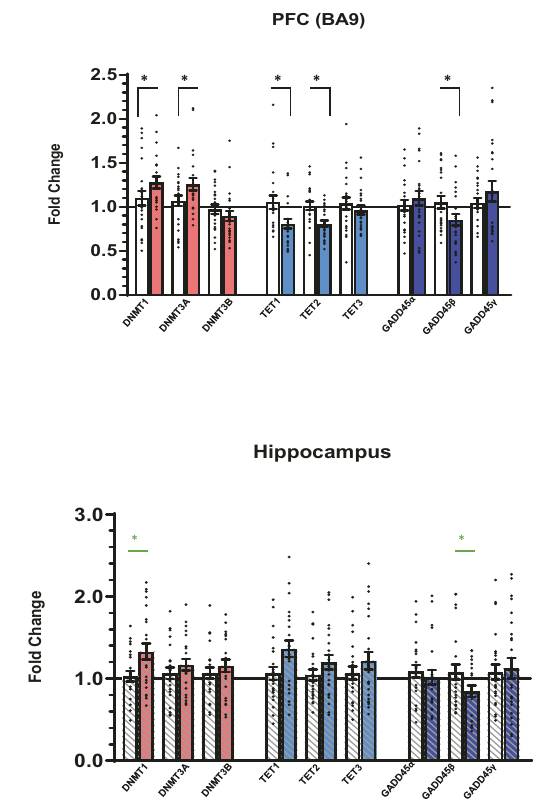
Fig. 4 Relative expression levels of DNA methylating and DNA demethylating enzymes. a Relative mRNA expression levels in the PFC of DNA methylating enzymes: DNMT1 (FC = 1.34, p = 0.02), DNMT3A (FC = 1.25, p = 0.02), DNMT3B (FC = 0.86, p = 0.11), DNA demethylating enzymes: TET1 (FC = 0.72, p = 0.03), TET2 (FC = 0.81, p = 0.02), TET3 (FC = 0.96, p = 0.52), GADD45 α (FC = 1.05, p = 0.43), GADD45 β (FC = 0.86, p = 0.03), GADD45 γ (FC = 1.05, p = 0.81). b In hippocampus: DNMT1 (FC = 1.27, p = 0.02), DNMT3A (FC = 1.10, p = 0.29), DNMT3B (FC = 1.07, p = 0.48), DNA demethylating enzymes: TET1 (FC = 1.28, p = 0.08), TET2 (FC = 1.12, p = 0.25), TET3 (FC = 1.11, p = 0.34), GADD45 α (FC = 0.92, p = 0.44), GADD45 β (FC = 0.78, p = 0.04), GADD45 γ (FC = 0.96, p = 0.6). White bars indicate normal-controls and lined/color- fi lled bars indicate suicide-completers for each target gene. Data are expressed as fold change (FC) ± SEM (error bars) after normalization to the geometric mean of internal controls and suicide-completers (T-SC) to normal- control (T-NC) subjects. N = 24/24, * p < 0.05, green * p indicates FDR corrected p is not signi fi